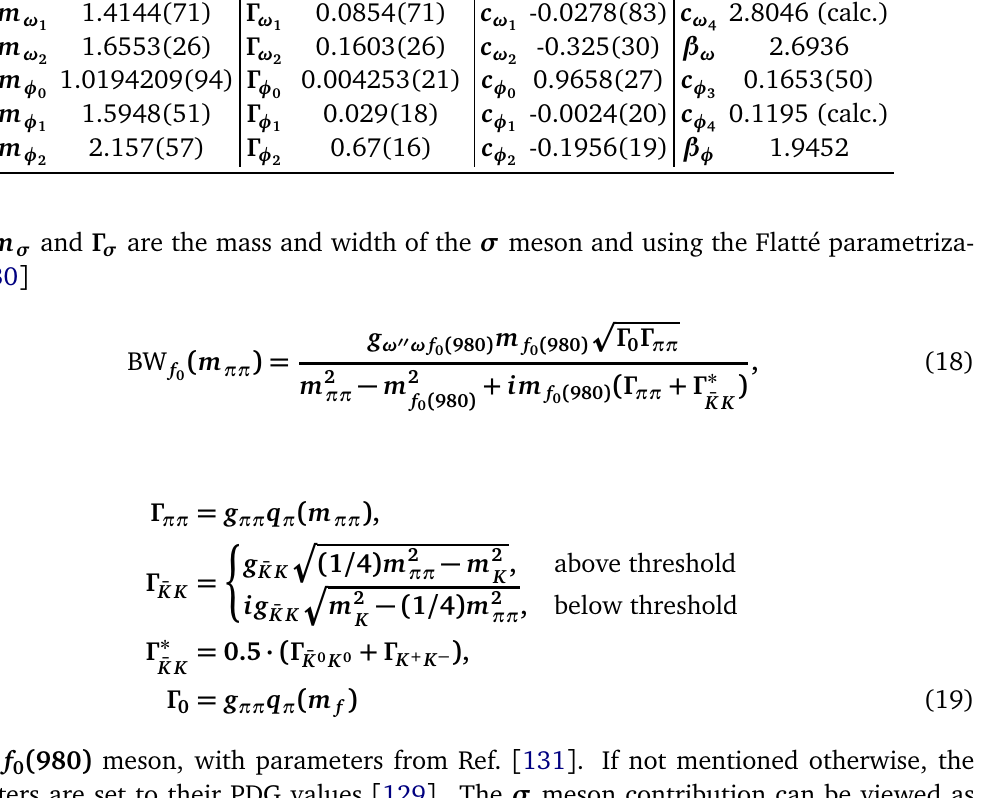
Table 6: Parameters for the 4 π channel for our fit using the model from [ 74 ] . All masses and widths are in GeV; couplings β j as c ρ are dimensionless; c